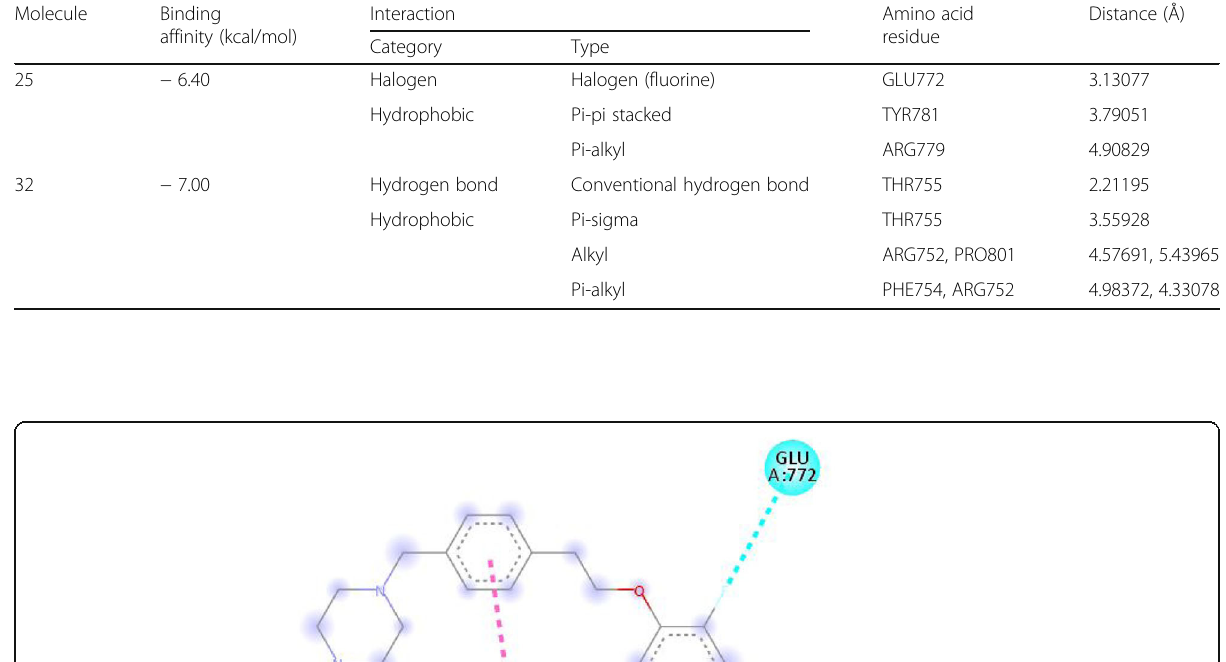
Table 8 Binding affinity and interaction between compounds 25 and 32 and the androgen receptor Molecule Binding affinity